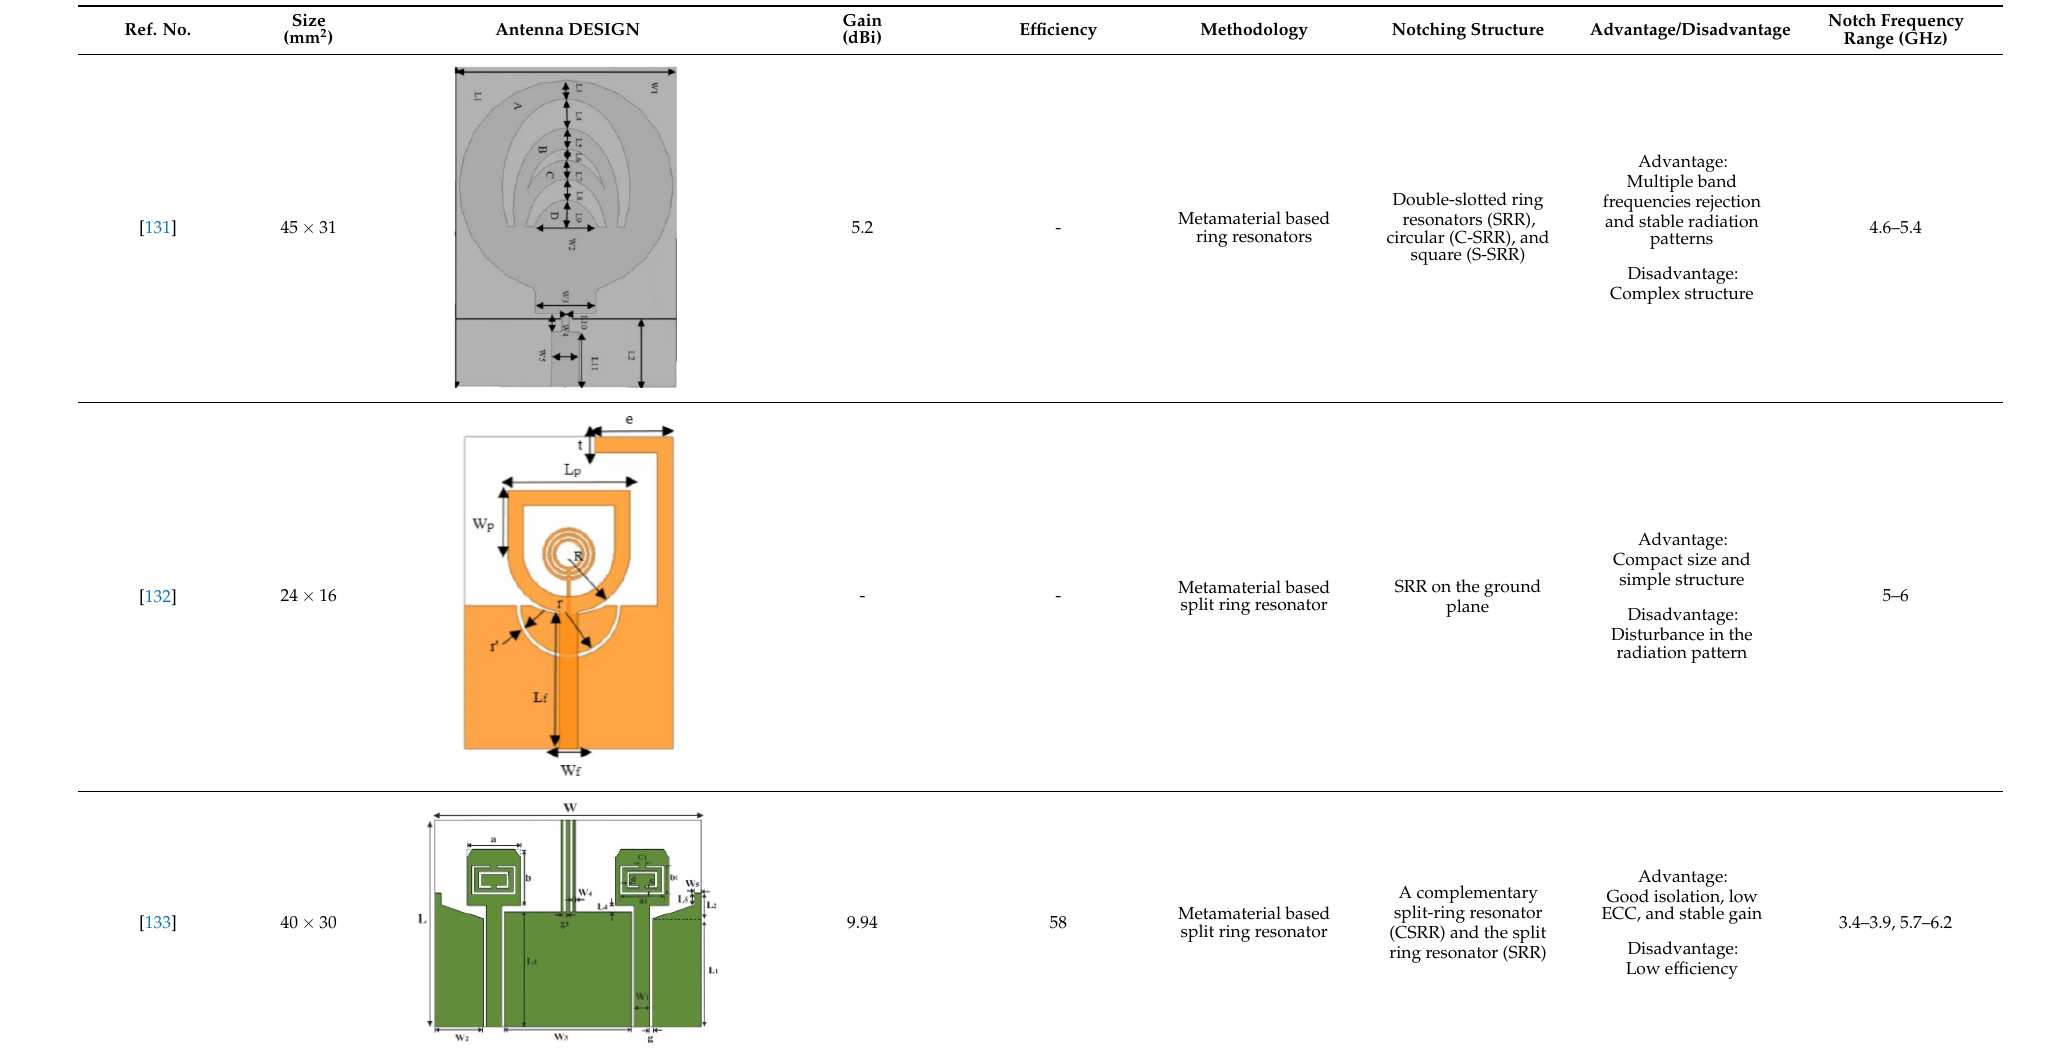
Advantage: Good isolation, low ECC, and stable gain Disadvantage: Low